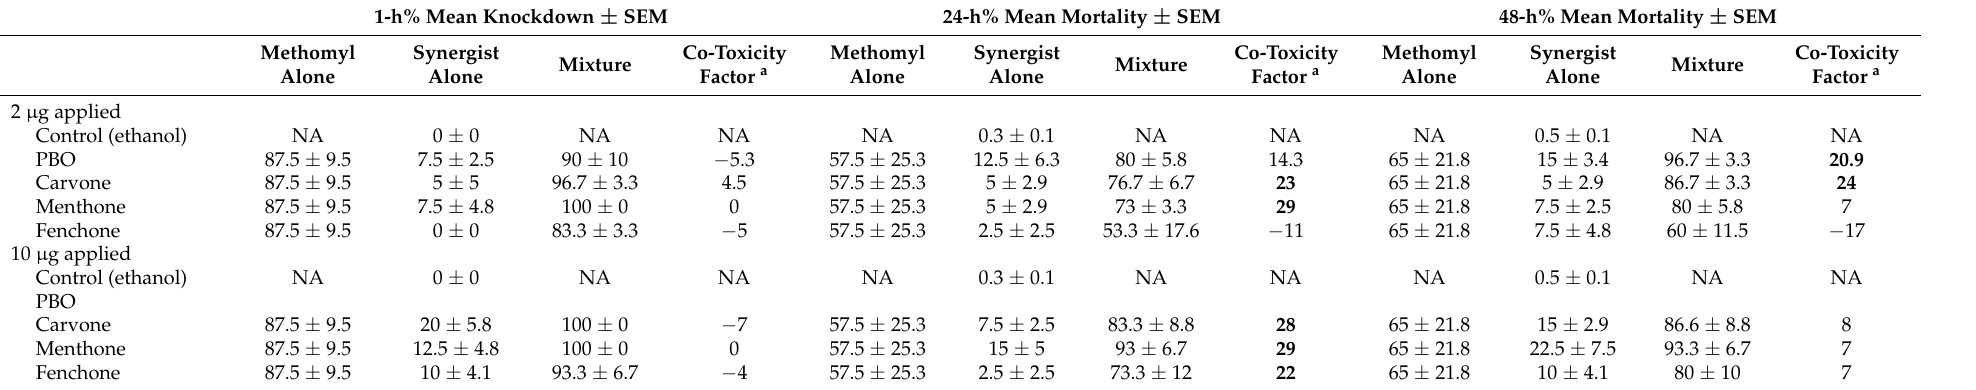
Table 3. Diagnostic doses and co-toxicity of L -carvone, L -menthone, and L -fenchone with methomyl against Aedes aegypti